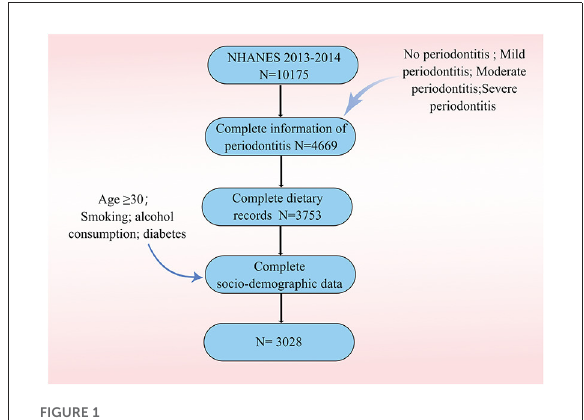
FIGURE1 The overview of the flow chart for this